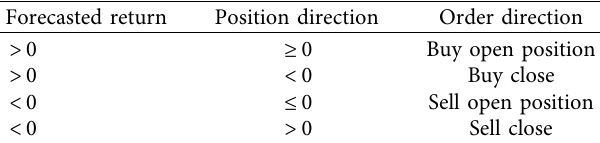
Table 4: Speculators’ order placing